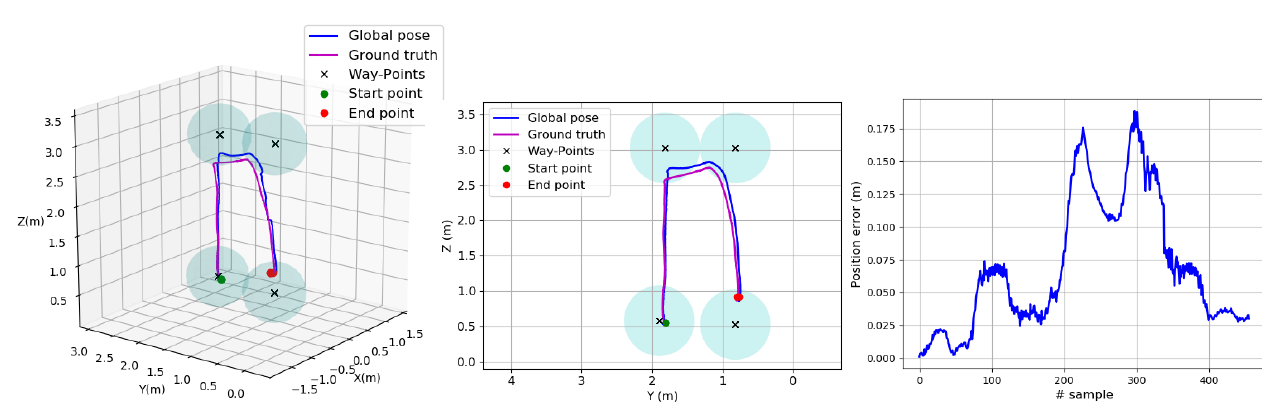
Figure 15. Autonomous vertical inspection: ( left ) estimated and true paths, ( middle ) 2D projection of the trajectory, ( right ) position estimation error. In the plots, × in the center of a blue sphere denotes a way-point. (All units are in meters.).